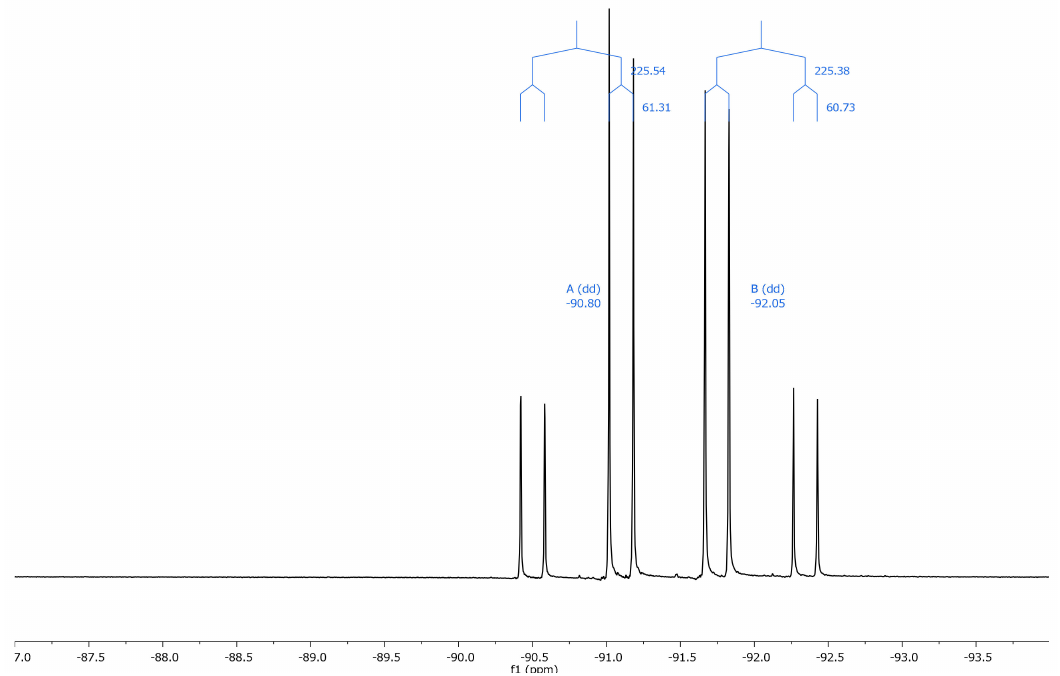
Figure 3. 19 F-NMR spectrum of 14 in CDCl 3 at 300 K with signals at − 90.80 ppm (dd, 2 J F = 225.5, 2 J 2 J − 92.05 (dd, 2 J H = 61.3), and F = 225.4, H = 60.7). The 2 J FF SSCC (spin-spin coupling constant) in F-C-F compounds is very sensitive to structural aspects, especially the C atom hybridization; for sp 3 carbons range between 3.5 and 340 Hz